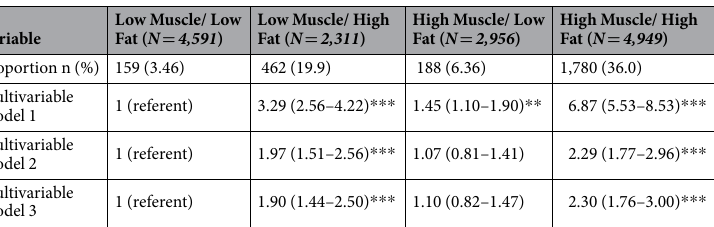
Table 3. Incidence rate ratio of (95% confidence intervals) for metabolic syndrome based on the NCEP ATP III criteria by muscle mass and fat mass. Data presented are n (%) and IRR (95% CI). Criteria for metabolic syndrome was defined as meeting three or more of the following conditions as suggested by the NCEP ATP III: (1) Impaired Fasting Glucose ( ≥ 100 mg/dL), (2) Elevated WC ( > 90 cm for men and > 85 cm for women), (3) High Blood Pressure (SBP: ≥ 130 mmHg and DBP: ≥ 85 mmHg), (4) High Triglyceride ( ≥ 150 mg/dL), (5) Reduced HDL-cholesterol ( < 50 mg/dL for men and < 40 mg/dL for women). Multivariable Model 1: Adjusted for age and sex. Multivariable Model 2: Adjusted for age, sex, education, employment status, area of residence, household income, smoking, alcohol consumption, sleep duration, physical activity, BMI, and presence of comorbidity. Multivariable Model 3: Adjusted for age, sex, education, employment status, area of residence, household income, smoking, alcohol consumption, sleep duration, physical activity, BMI, and presence of comorbidity, total energy intake, vitamin C, niacin, sodium, calcium, and fiber. Abbreviations: IRR, Incidence Rate Ratio; CI, Confidence Interval; WC, Waist Circumference; SBP, Systolic Blood Pressure; DBP, Diastolic Blood Pressure; HDL, High Density Lipoproteins; NCEP ATP III, National Cholesterol Education Program- Adult Treatment Panel III; Note: Each category of muscle mass and fat mass is compared to low muscle/low fat group (reference). * p < 0.05, ** p < 0.01, *** p < 0.001 (reference group is low muscle/low